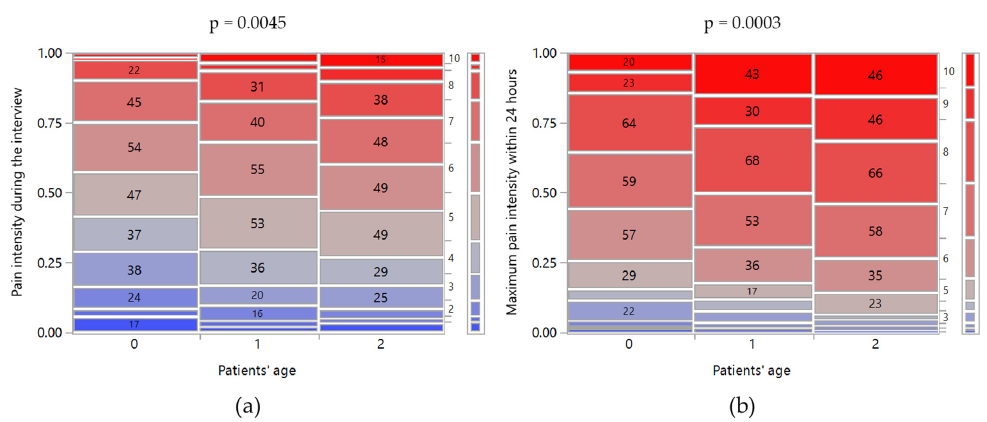
Figure 1. Mosaic plots of scores of ( a ) pain intensities during the interview and ( b ) maximum one within 24 h before versus patient’s age levels: 0 < 40 years old; 1, 40–52 years old; 2, > 52 years old. The class counts were reported inside the mosaic plots. Above the graph is the p -value of Pearson’s chi-squared test between the two variables.